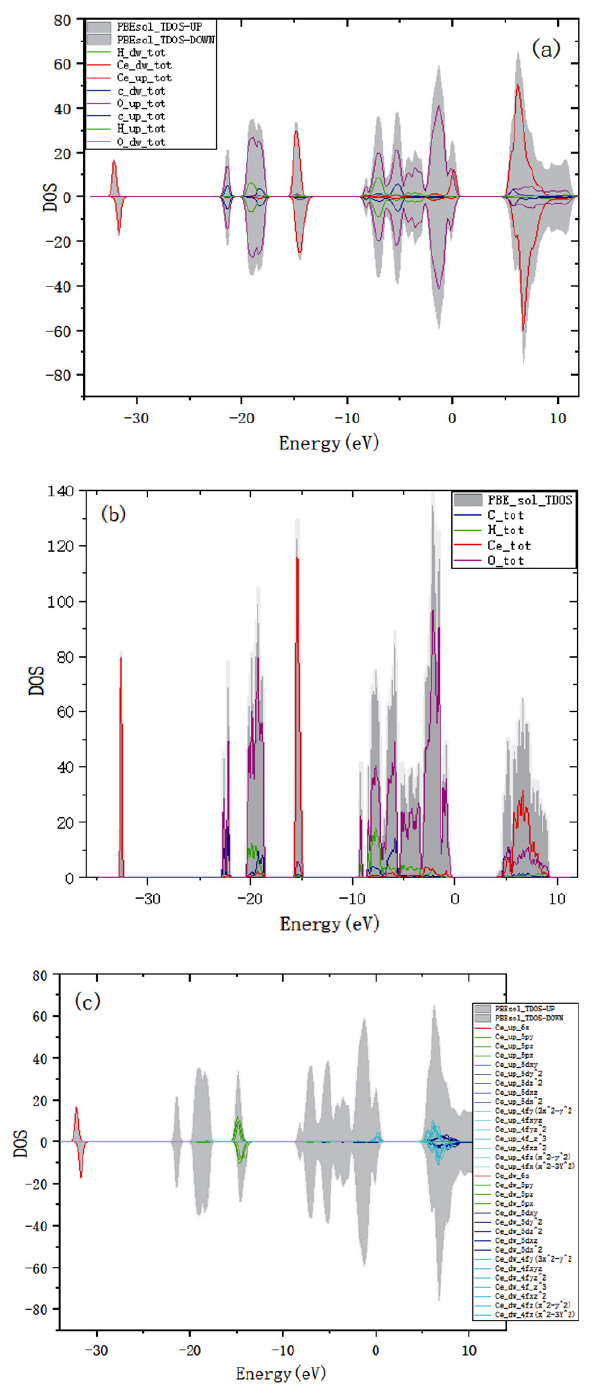
Figure 1. DOS and PDOS plots calculated by PBEsol functional (a) DOS and PDOS plots calculated by PBEsol+U pseudopotential (b) DOS and PDOS plots calculated by PBEsol simplified pseudopoten- tial (c) PDOS plots calculated by PBEsol+U for